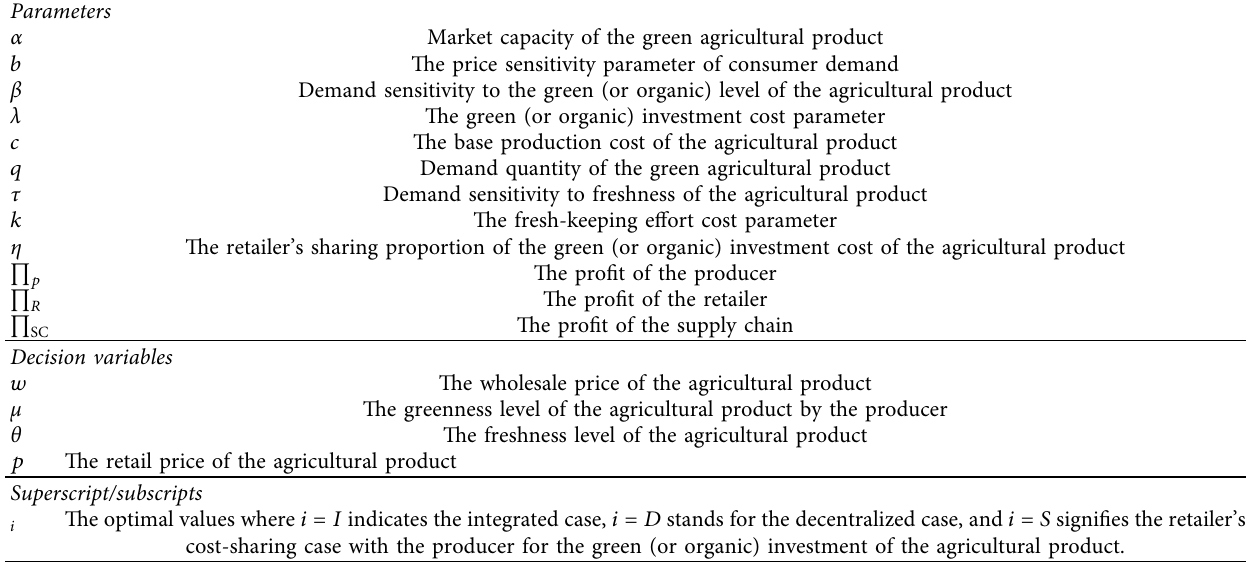
Table 1: The notations in the APSC decision